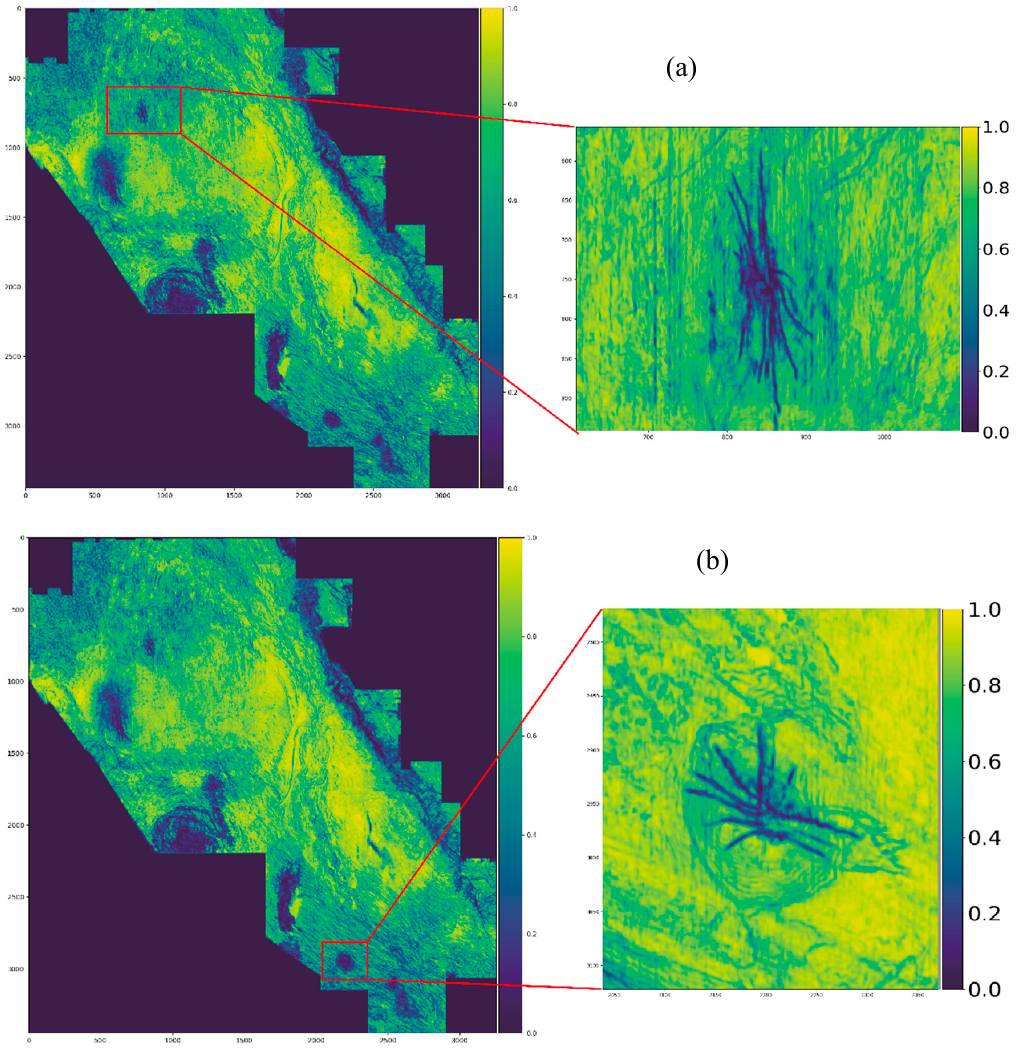
Figure 5. The coherence values and fracture interpretations in the diapir areas of DF1-1 ( a ) and LD15-1 ( b ).